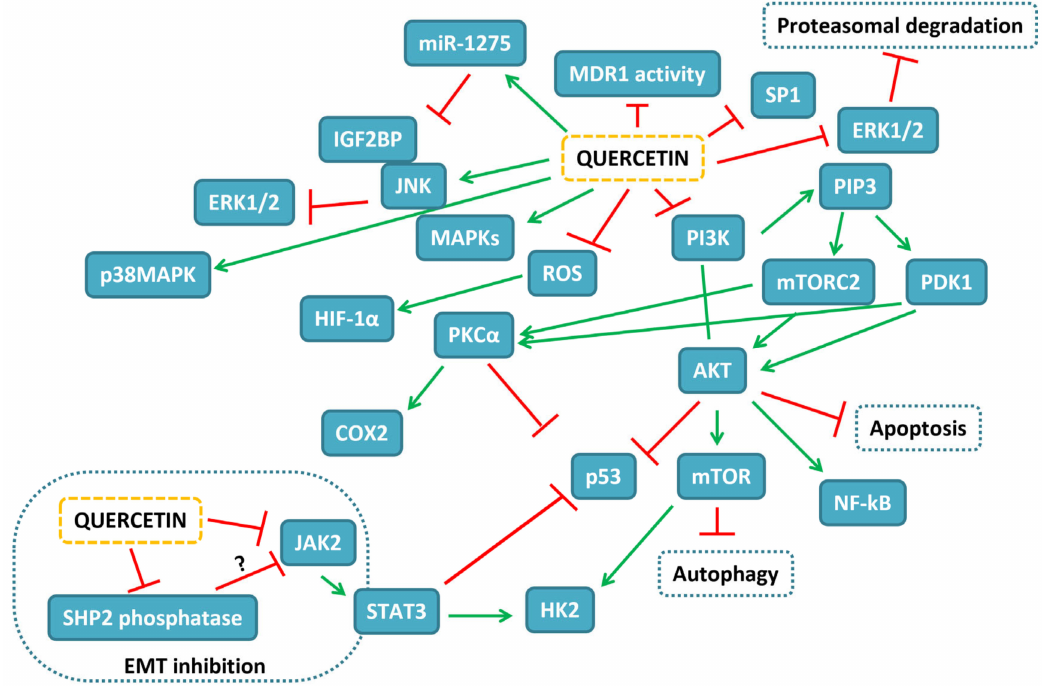
Figure 3. Map of the interactions of quercetin in HCC experimental models. In blue-filled boxes, the proteins influenced by quercetin treatment are reported, while blue-dashed boxes indicate cellular events. Red T-shaped lines correspond to inhibition, while green arrows correspond to